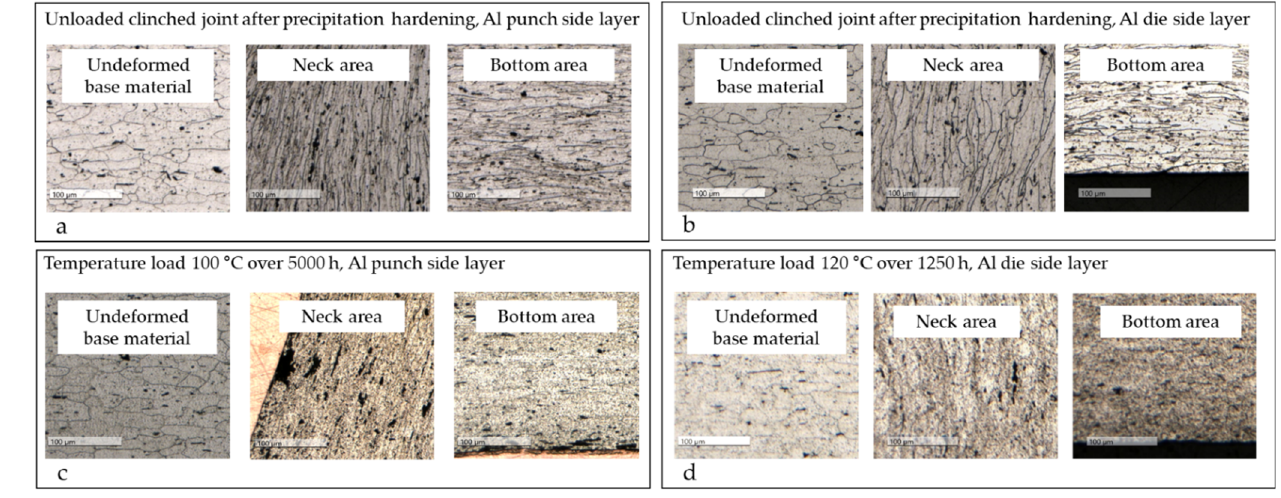
Figure 12. ( a , b ) Microstructural condition after clinching without load, ( c , d ) after a thermal load. In the neck area, the crystallites are axially elongated. In the bottom area, the crystal- lites are radially elongated as a result of the material flow to adjust the bottom thickness.